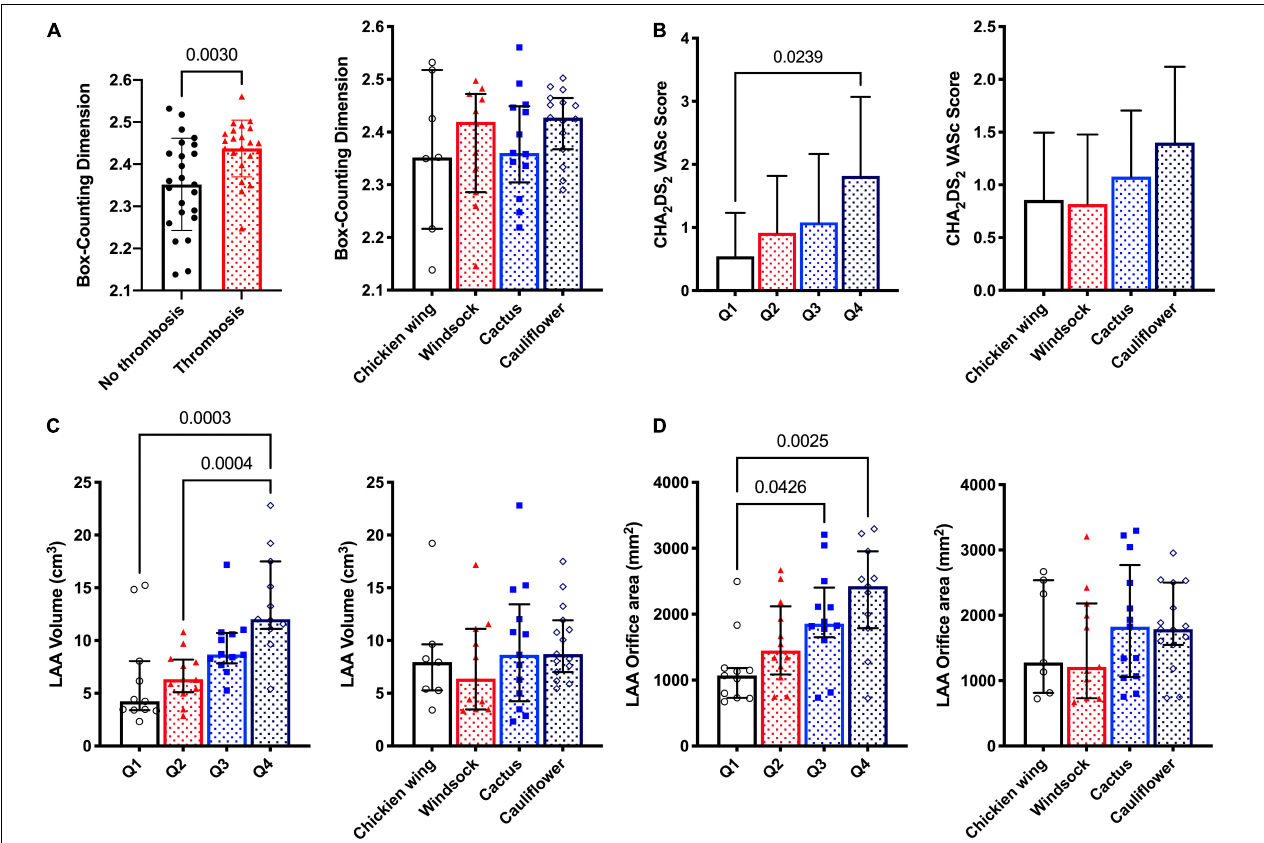
FIGURE 3 | Comparison of box-counting dimension and other LAA parameters. (A) The LAA box-counting dimension of patients with AF and thrombi was significantly higher than that of patients without thrombi ( p = 0.003), yet the box-counting dimension was not statistically different between the four types of LAA. (B) Comparison of CHA 2 DS 2 -VaSc between four groups divided by quartile indicated that the CHA 2 DS 2 -VaSc score was markedly higher in Q4 group compared to Q1 group, while it appeared no significant difference between four types of LAA. (C) LAA volumes of patients in Q4 were dramatically larger than those of patients in the Q1 and Q2 groups, and no difference was observed in four types of LAA. (D) Similar to LAA volume, the LAA orifice area was also significantly larger in the Q4 group.